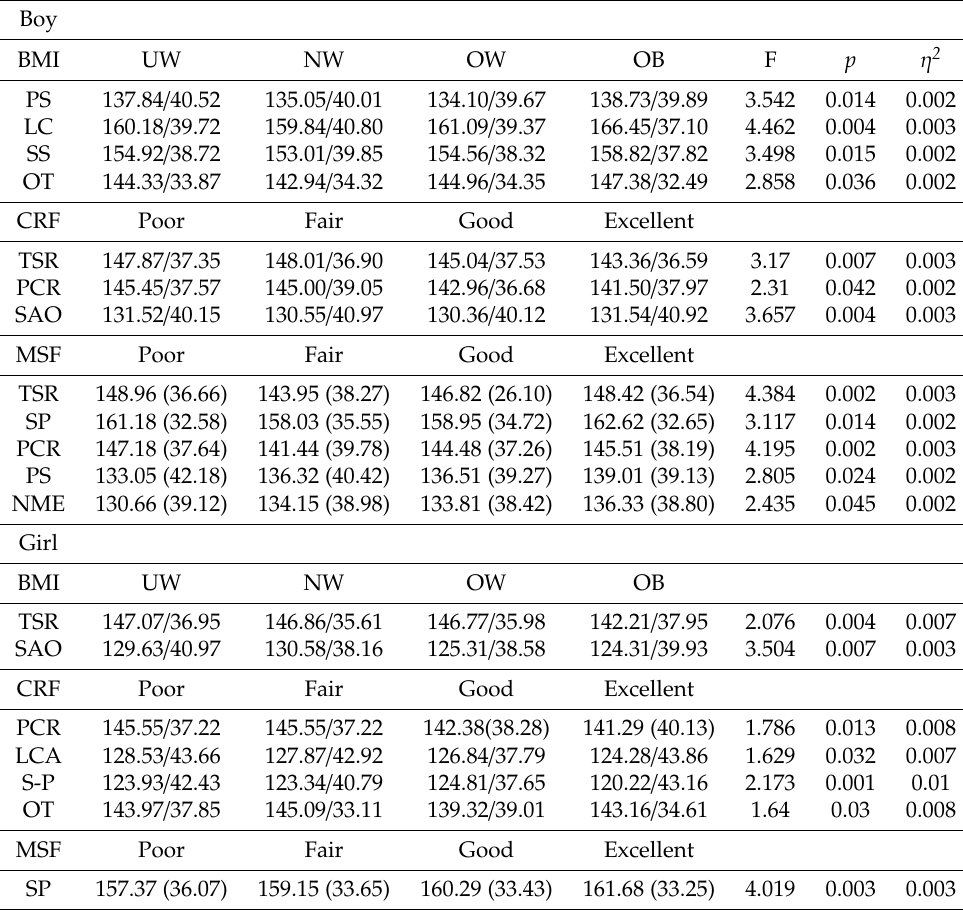
Table 2. Analysis of Covariance of BMI, CRF, and MSF.